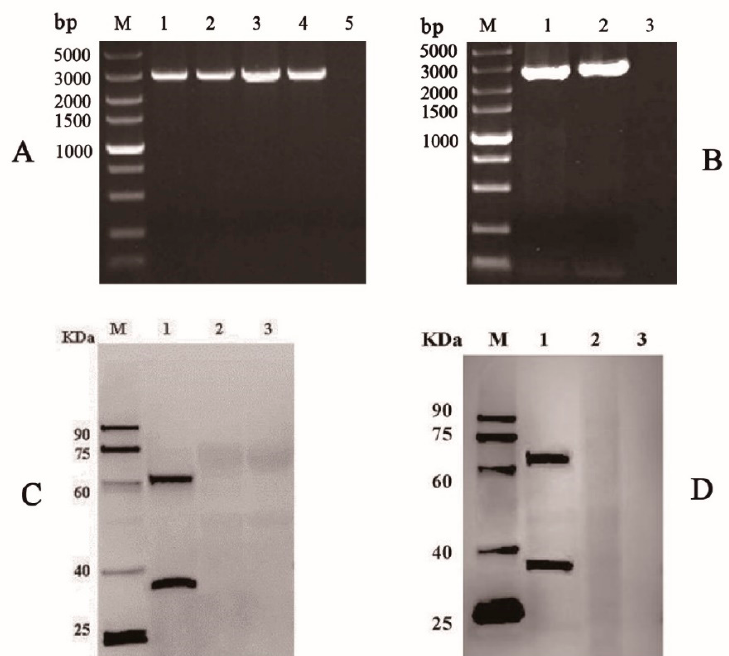
Figure 3. Confirmation and expression analysis of VP35-VP4 in BmE cells and hemolymph of silkworms by PCR and Western blotting. ( A ) PCR amplification of VP35-VP4 from the genome DNA of P1, P2, and P3 recombinant baculoviruses in BmE cells: Lane M, DNA marker; Lanes 1–3, P1–P3 rBmBac-VP35-VP4; Lane 4, rBmBacmid-VP35-VP4; Lane 5, rBmBac-wild. ( B ) PCR amplification of VP35-VP4 in hemolymph of silkworms: Lane M, DNA marker; Lane 1, Hemolymph of silkworms infected with rBmBac-VP35-VP4; Lane 2, rBmBacmid-VP35-VP4; Lane 3, rBmBac-wild. ( C ) (Figure S1) Western blotting analysis of rVP35-VP4 expression in BmE cells: Lane M, protein marker; Lane 1, BmE cells infected with rBmBac-VP35-VP4; Lane 2, BmE cells infected with rBmBac-wild; Lane 3, normal BmE cells. ( D ) (Figure S2) Western blotting analysis of rVP35-VP4 expression in